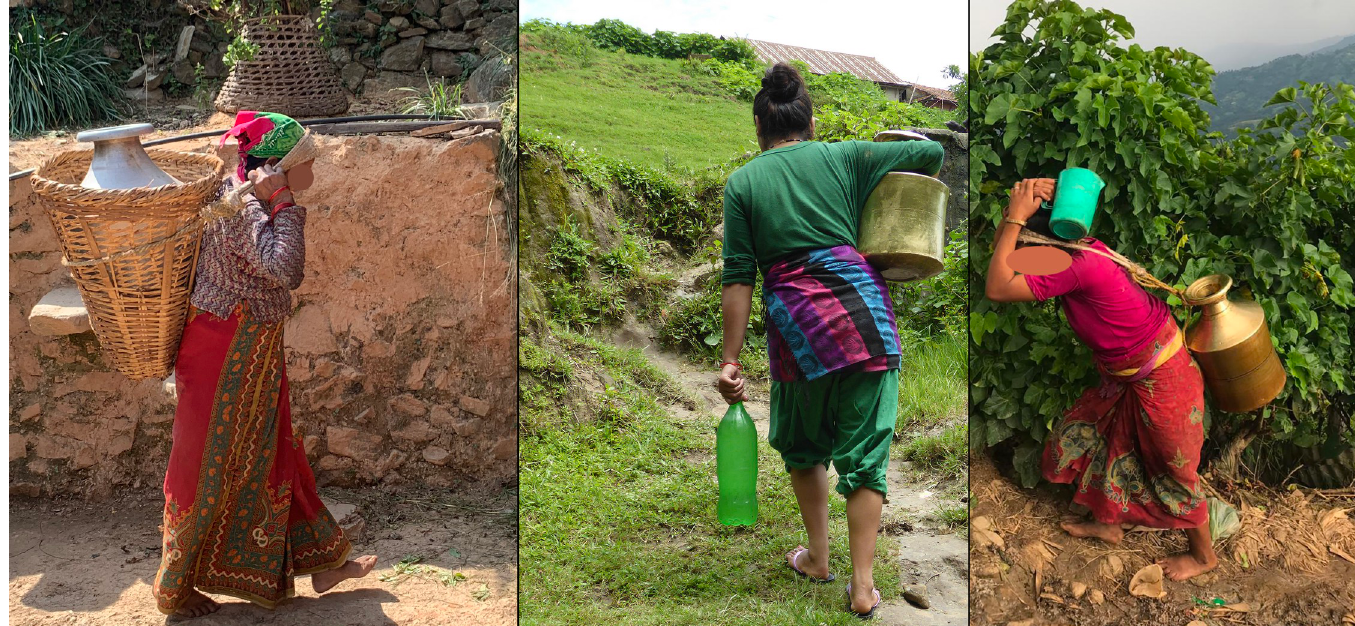
Fig 1. Water carrying with basket (doko) and straps (namlo) and on the